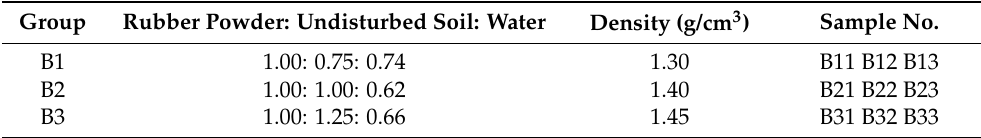
Table 2. Group B: rubber powder + undisturbed soil (rubber powder soil).